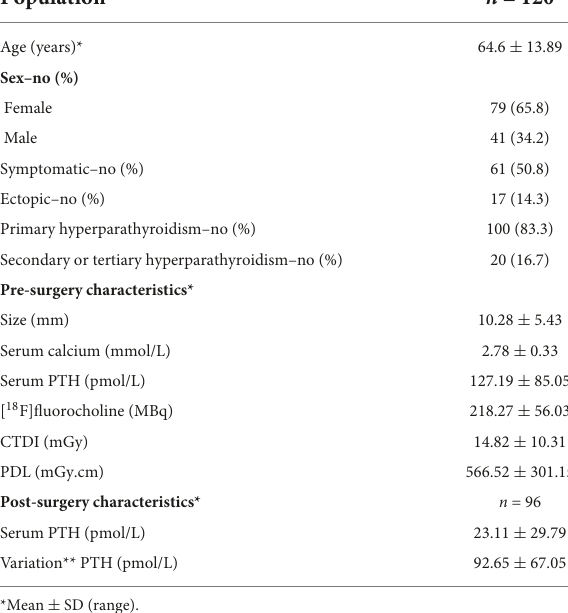
TABLE 1 Population characteristics and biological results.